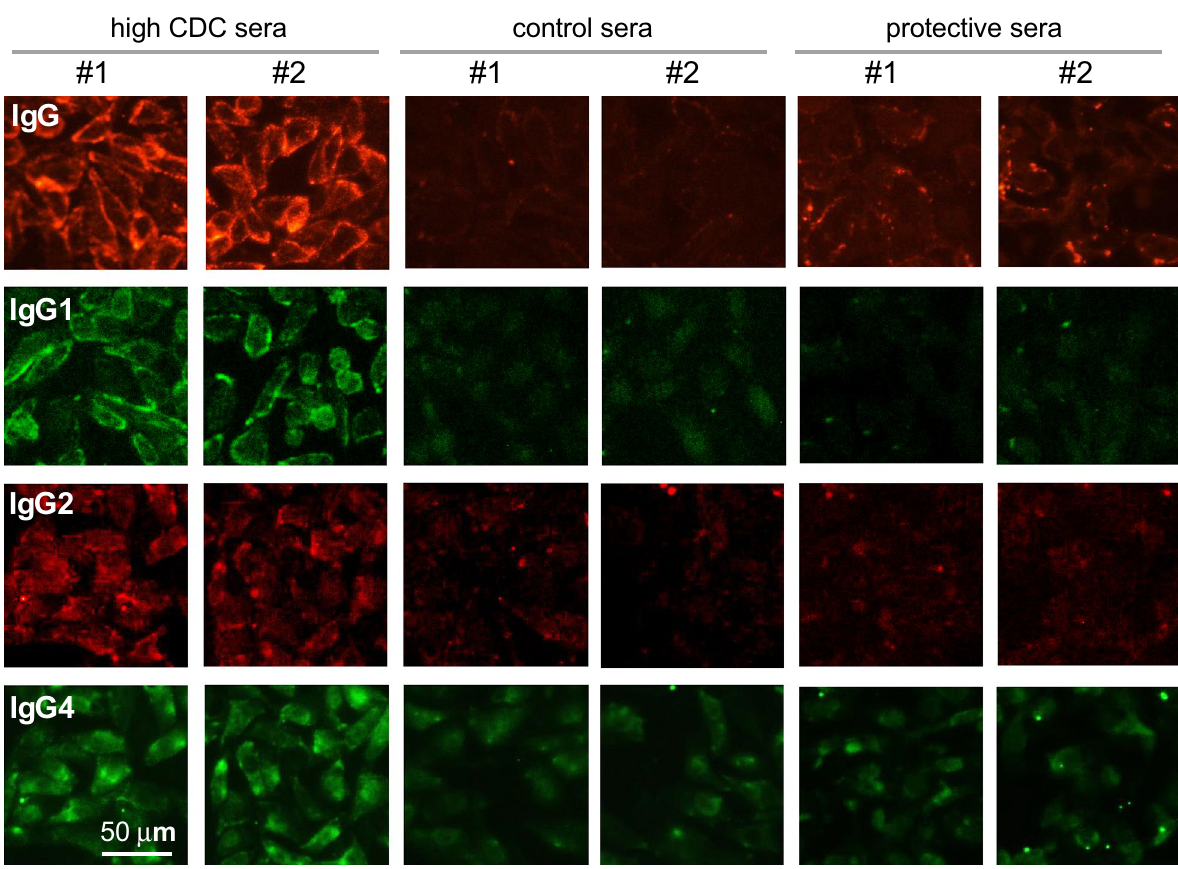
Figure 5. Absence of AQP4-bound IgG2 and IgG4 subclass antibodies in cytoprotective sera. AQP4-expressing CHO cells incubated for 60 min with 10% control (no cytotoxicity) sera, cytoprotective sera, or high